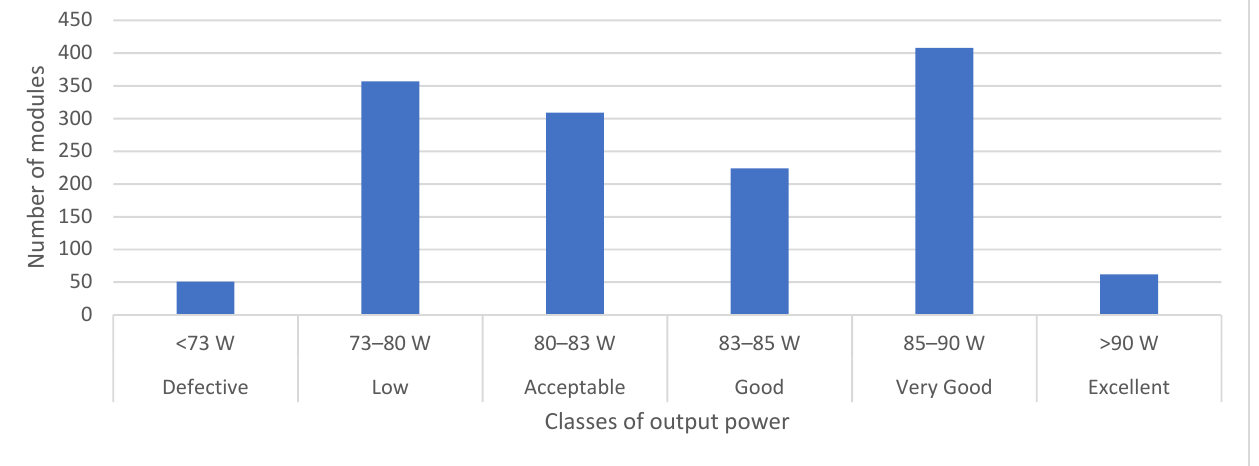
Figure 4. Classification of the d-serie laser modules based on output power.